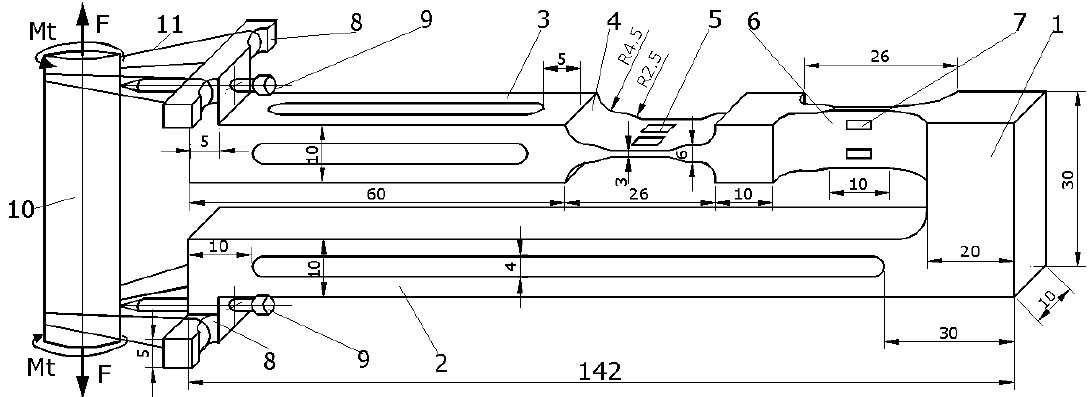
Figure 2. The general image of the extensometer.